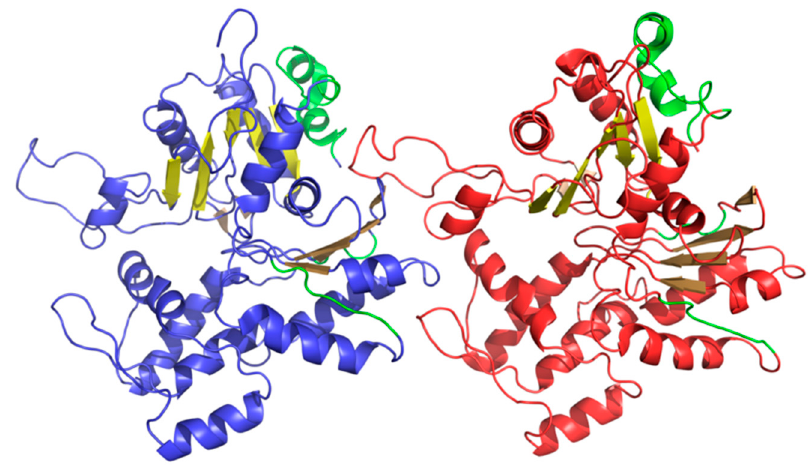
Figure 11. 3D presentation of F chain (blue) and H chain (red) from F-actin (PDB ID 3J8I). Beta sheets are displayed in different shades of yellow (same three shades in each chain). “Stop” fragments are shown in green.